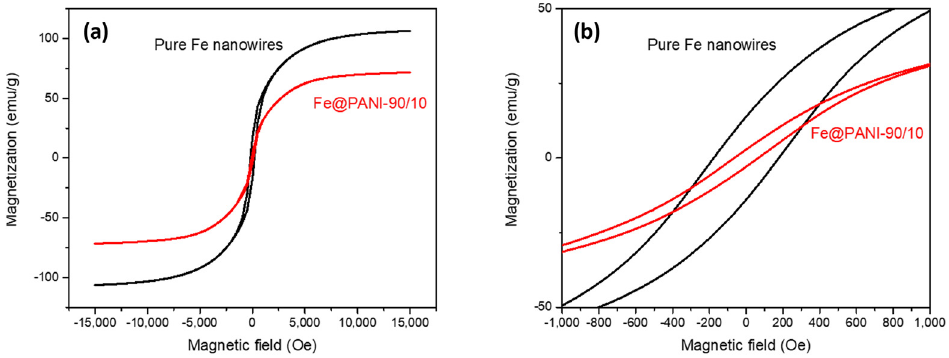
Figure 9. SQUID VSM results of some typical Fe@PANI nanowires.